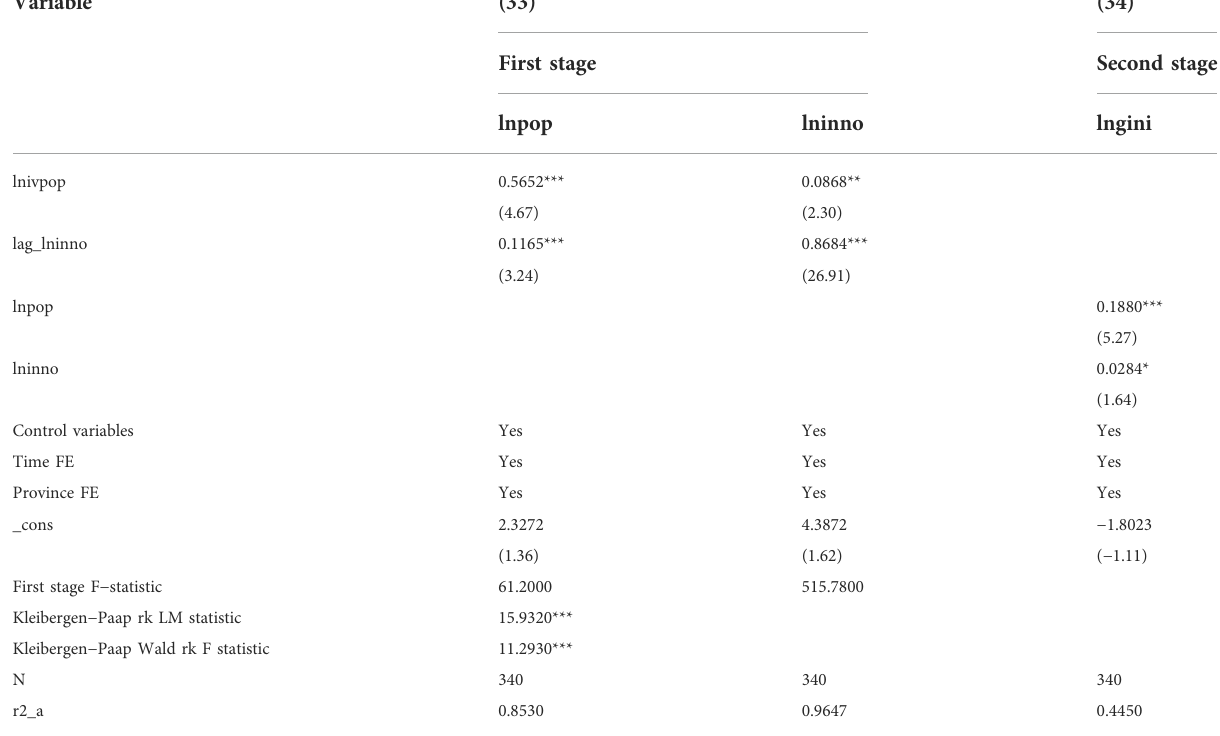
TABLE 11 Endogeneity